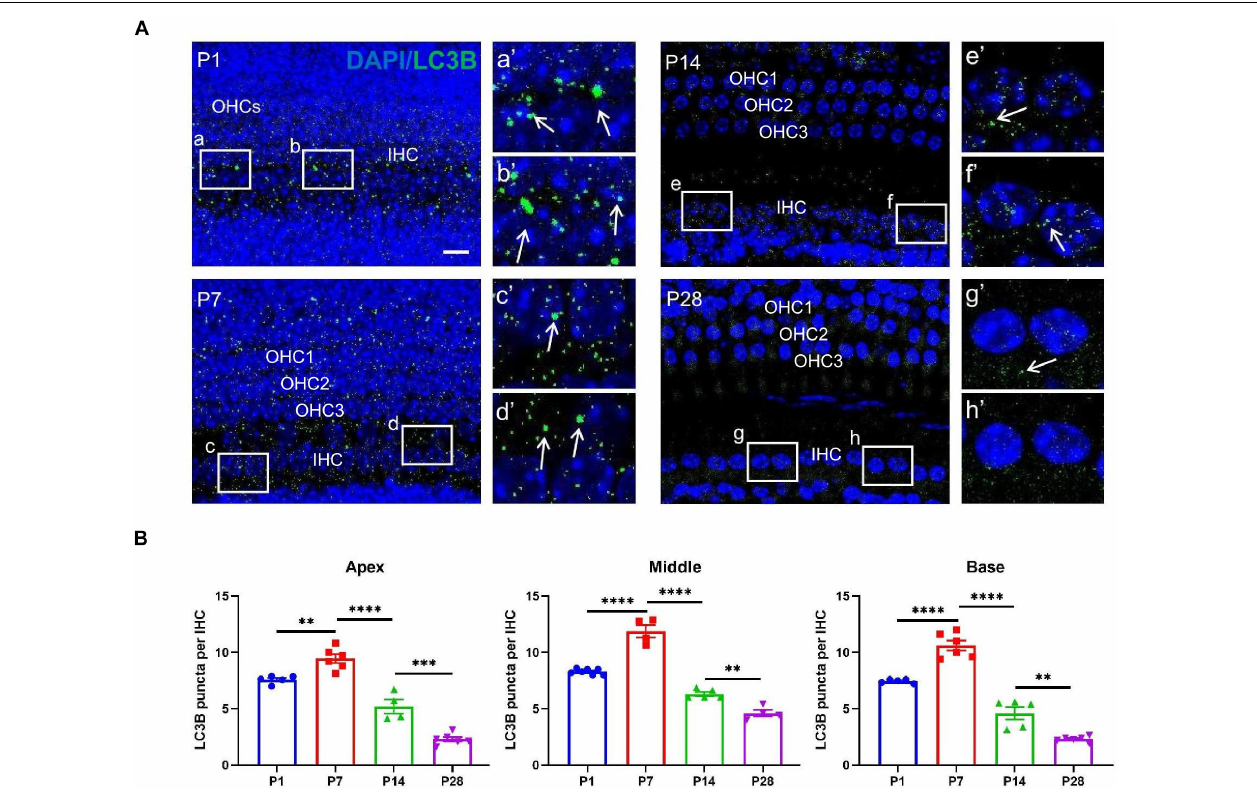
FIGURE 4 | LC3B detection in the ribbon synapses regions. (A) Autophagic flux was identified using anti-CtBP2 (green, white arrows). White frames at P1 (a,b) , P7 (c,d) , P14 (e,f) , and P28 (g,h) indicate the regions of ribbon synapses; (a (cid:48) – h (cid:48) ) are enlarged images of panels (a–h) , respectively. Scale bar = 5 µ m. (B) Quantitative analysis of the number of LC3B puncta at P1, P7, P14, and P28. The highest number of LC3B puncta was identified at P7, and significant reductions in LC3B puncta were observed at P14 and P28 (* p < 0.01; *** p < 0.001; **** p < 0.0001).